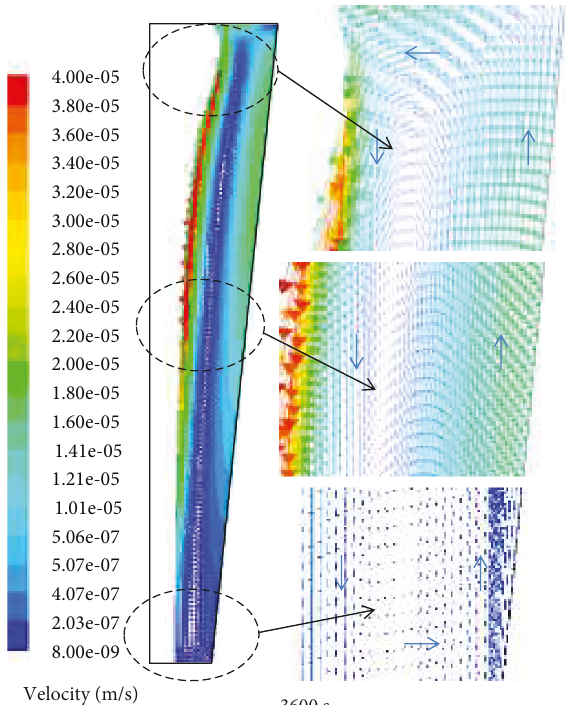
Figure 13: The simulated liquid PCM velocity fi eld with truncated cone TES unit during discharging